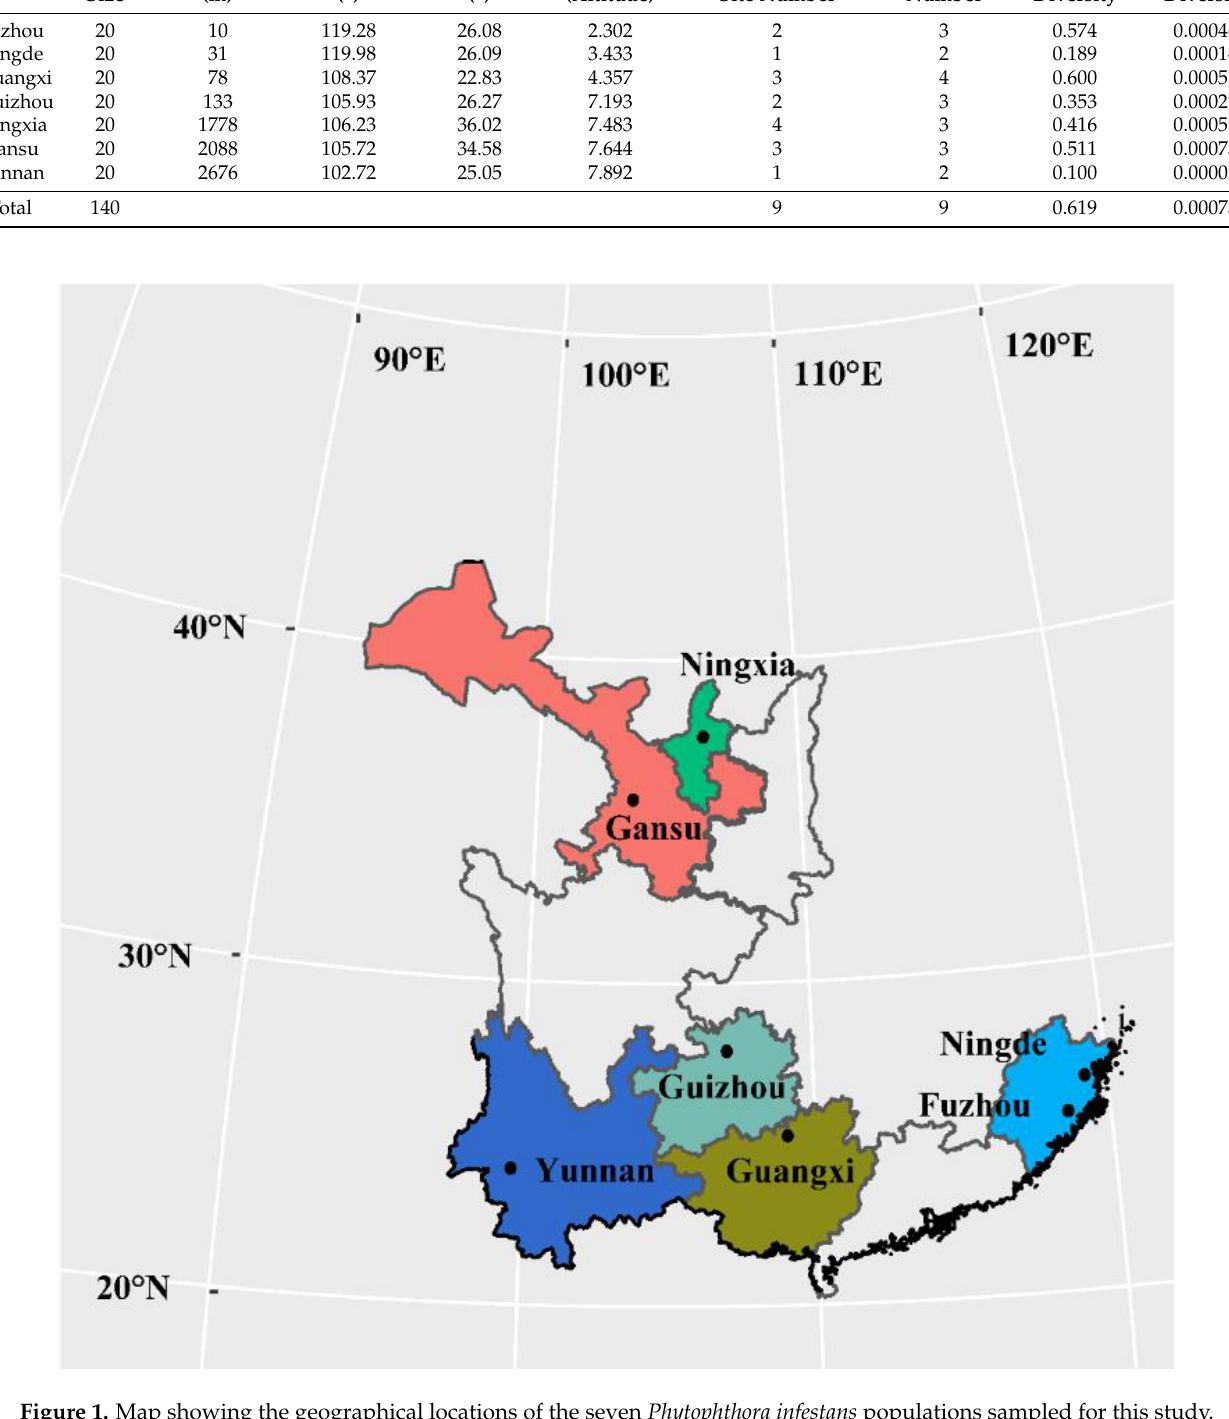
Table 1. Sample size, geographic origin, and genetic diversity of RAD23 in the seven Phytophthora infestans populations